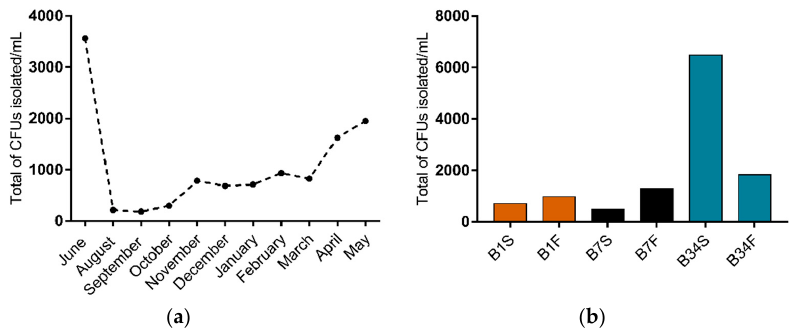
Figure 1. Distribution of CFU isolated on TCBS agar from Guanabara Bay’s waters over the course of one year. ( a ) Distribution of total CFU/mL isolated in each sampling expedition from June/2018 to May/2019. ( b ) CFU/mL isolated in each sampling site, from the subsurface as well as from the bottom water samples. B1S: site 1 subsurface; B1F: site 1 bottom; B7S: site 7 subsurface; B7F: site 7 bottom; B34S: site 34 subsurface; B34F: site 34 bottom.